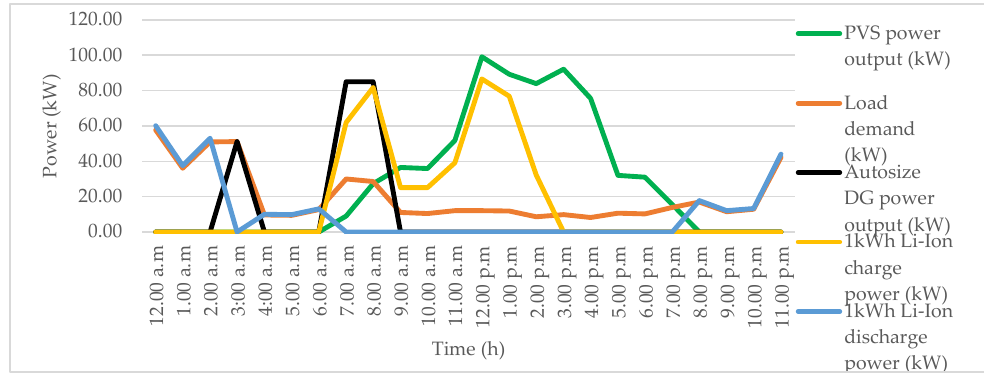
Figure 13. Daily time-stamped analysis for the month of June. In Figure 14, the operation of inverter on 20 June using a solar DG source with TSVA tracking technique is shown. The inverter input is DC source and the output is AC source. The 1 kWh Li-Ion battery SOC varies between 20% and 100%. The battery discharges till 20% only as per the constraints. When the battery discharges till 0% or less than 20%, then it affects the lifetime of battery. The household and electric load-2 requires AC